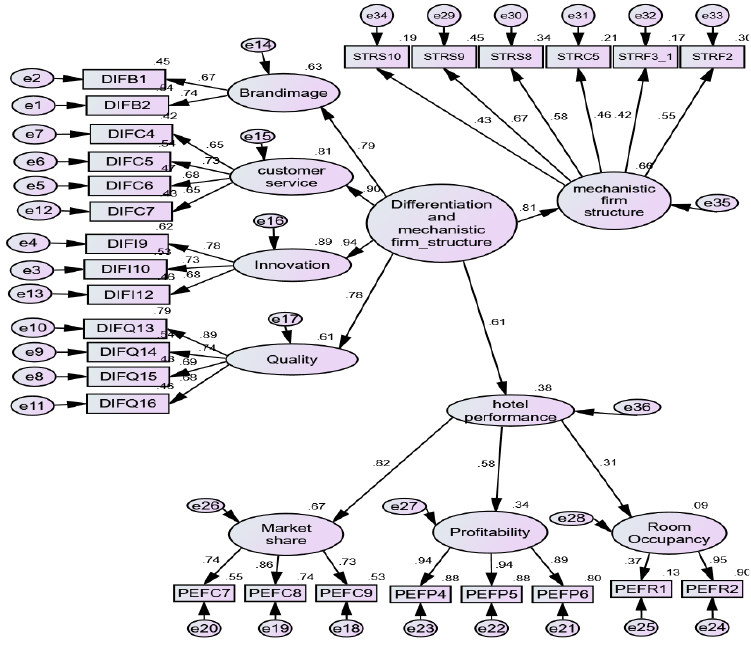
Figure 3: Structural equation model on joint influence of differentiation strategy and mechanistic firm structure on organizational performance of star rated hotels in